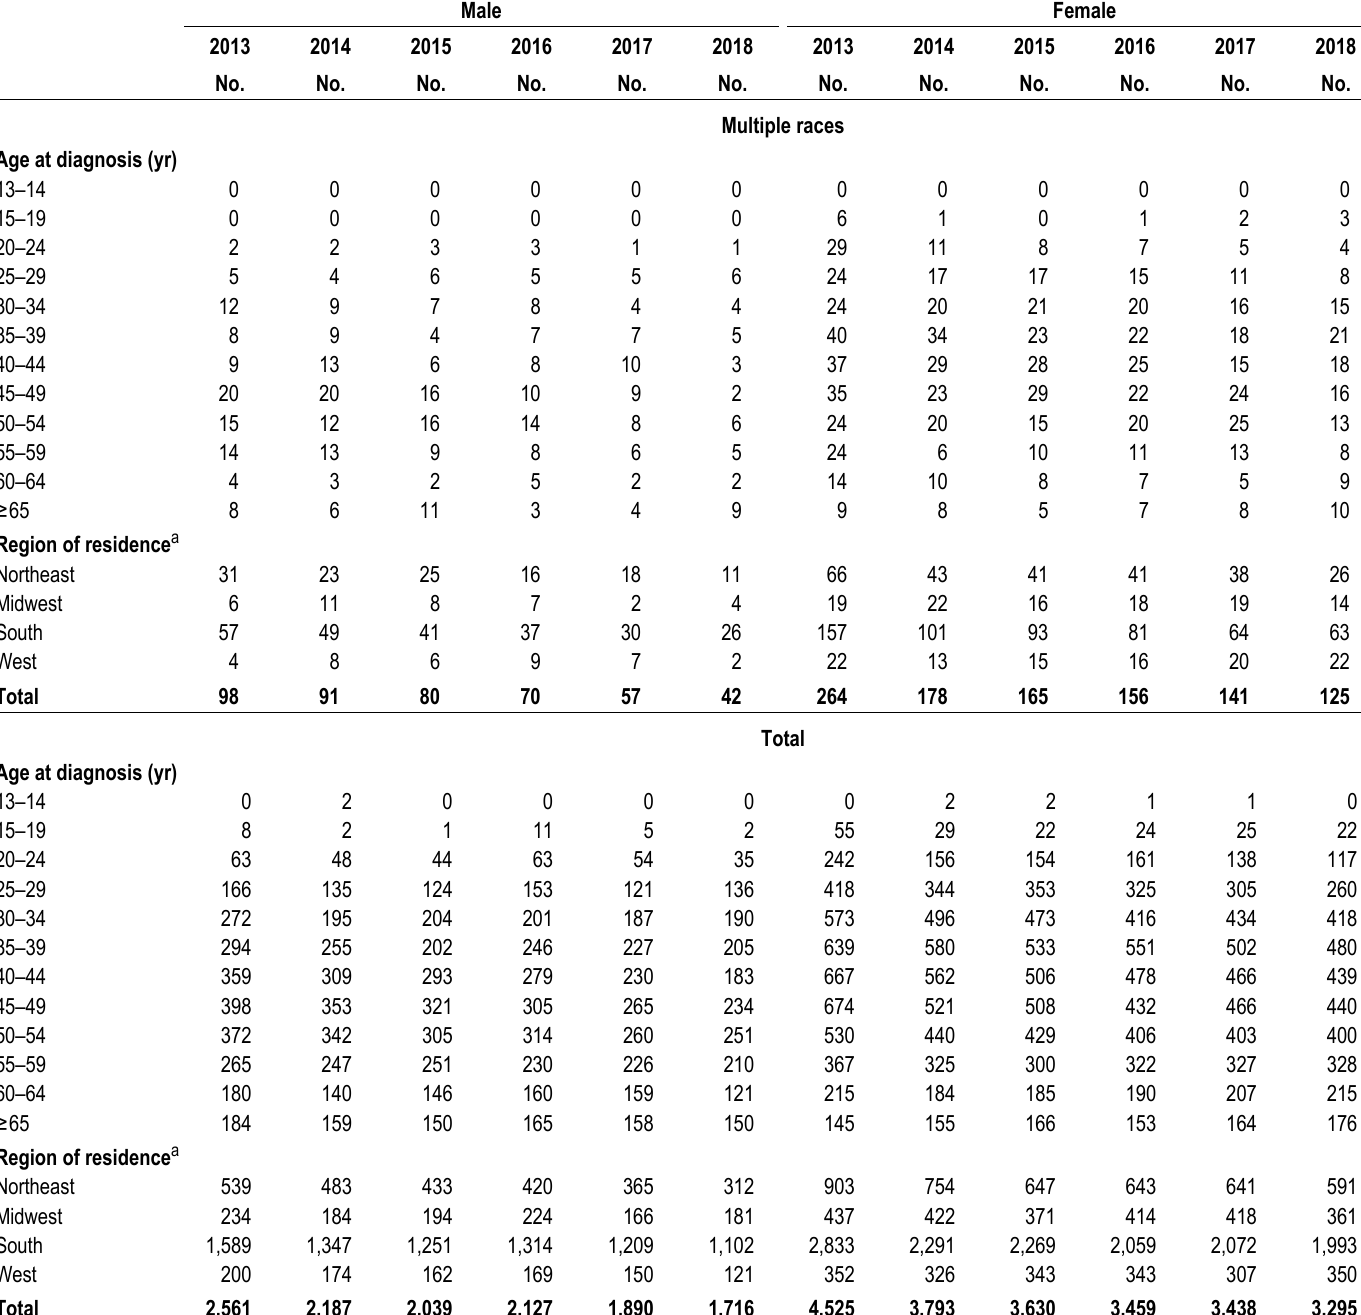
Table 12a. Stage 3 (AIDS) attributed to heterosexual contact, by selected characteristics, 2013–2018—United States (cont)